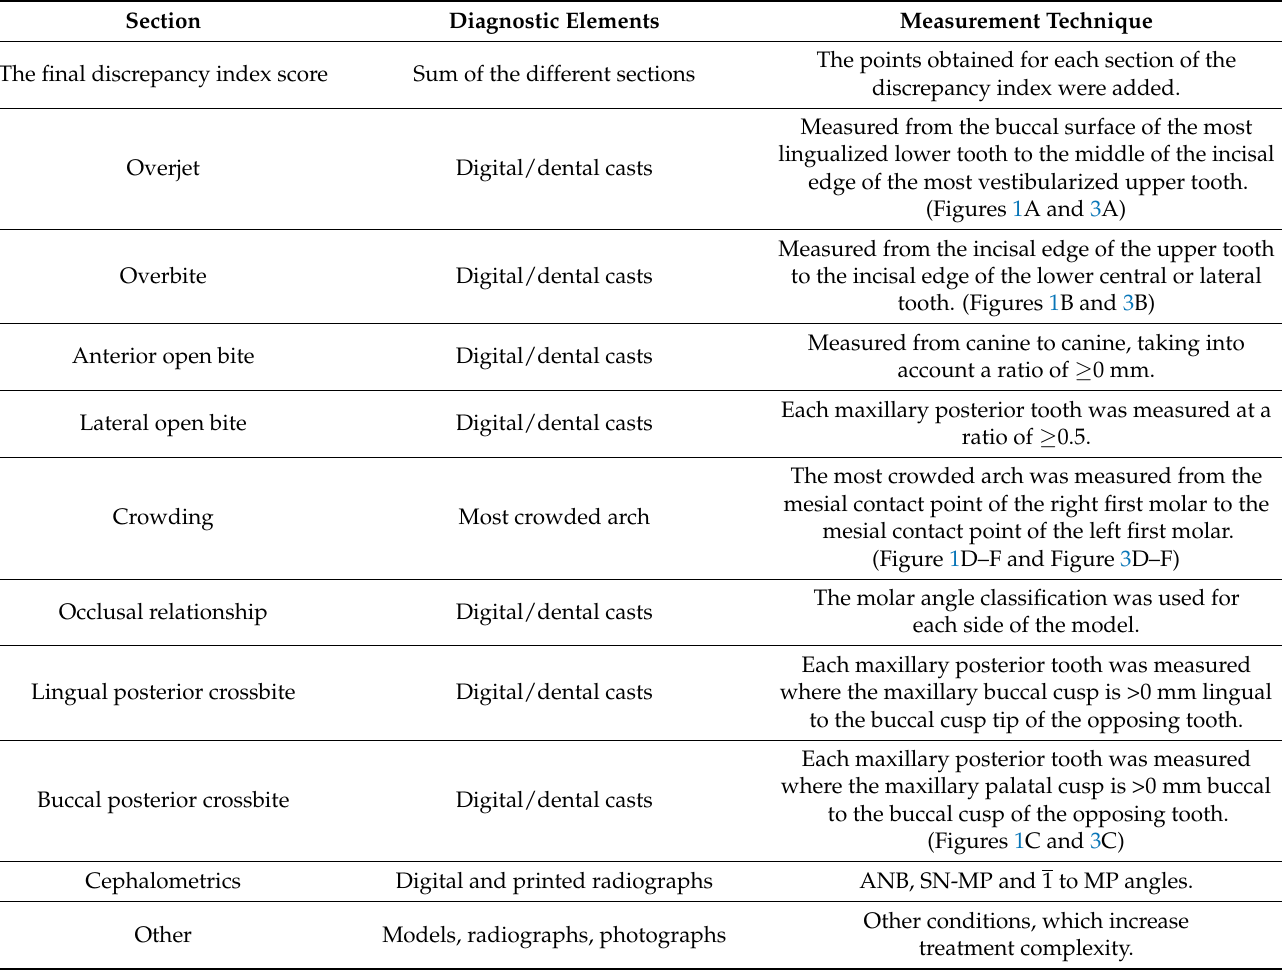
Table 1. The discrepancy index score